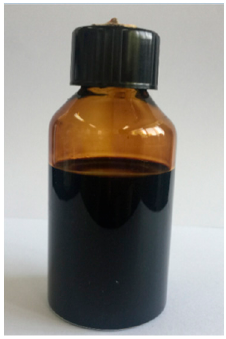
Figure 1. Homogeneous PAN/EHL composite solution.